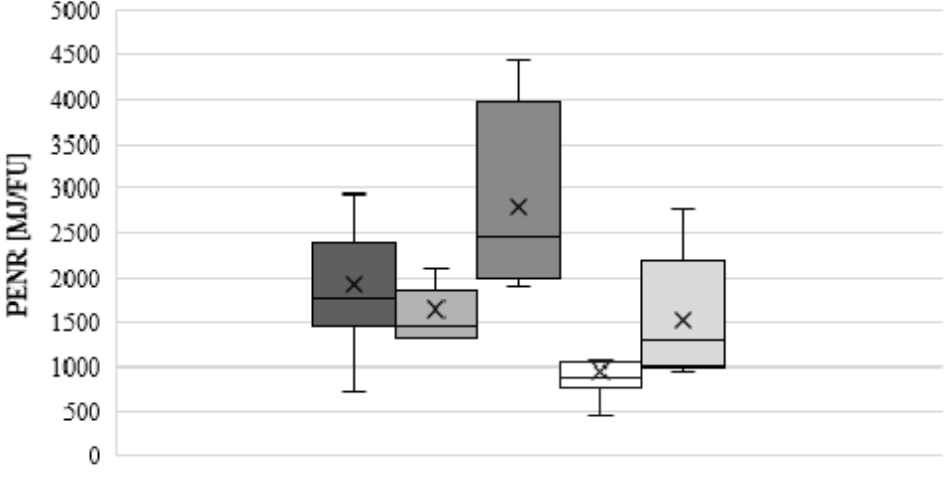
Figure 3. Embodied impacts of double-glazed window for different frame material: ( a ) PERN, ( b ) PER, ( c ) GWP.